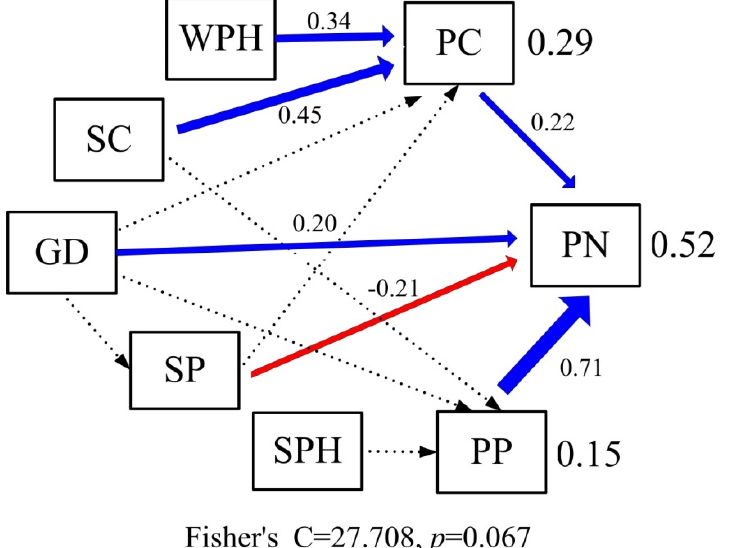
Figure 5. Controlling factors analysis of variations in leaf C, N, and P concentrations of A. sparsifolia in the study sites using the structural equation model. Significant regressions and nonsignificant regressions are shown by solid ( p < 0.05) and dashed lines, respectively. The thickness of significant paths was scaled on the basis of magnitude of the standardized regression coefficient. Blue and red arrows denote positive and negative relationships, respectively. GD, groundwater depth; WPH, groundwater pH; WM, degree of mineralization of groundwater; SS, soil salt; SPH, soil pH; SC, soil C concentration; SN, soil N concentration; SP, soil P concentration; PC, plant C concentration; PN, plant N concentration; PP, plant P concentration; PNP, plant N:P